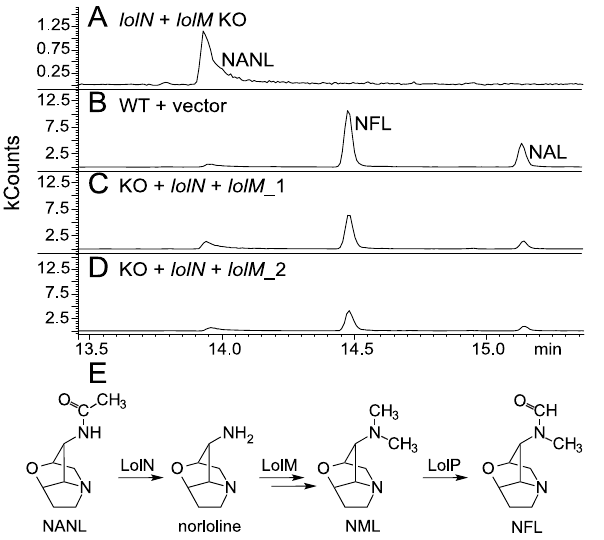
Fig. 4. GC-MS traces showing loline-alkaloid profiles of meadow fescue symbiotic with different E. festucae strains. (A) The lolN - lolM knockout (KO), (B) an empty-vector control transformant (WT + vec), and (C and D) complementation strains (KO + lolN + lolM ). The numbers after complementation strains represent different meadow fescue plants inoculated with independent transformants. (E) Proposed roles of LolN and LolM (this work), and reported role of LolP [14], in the biosynthetic pathway from N -acetylnorloline (NANL) to the final product, N -formylloline (NFL).